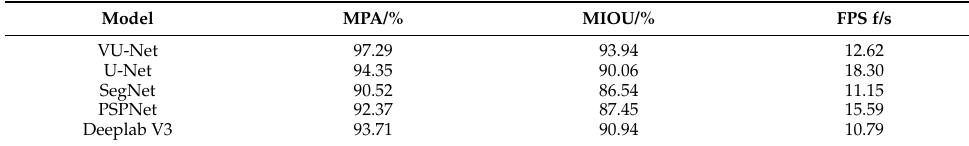
Table 2. Comparison of the prediction results of different models.